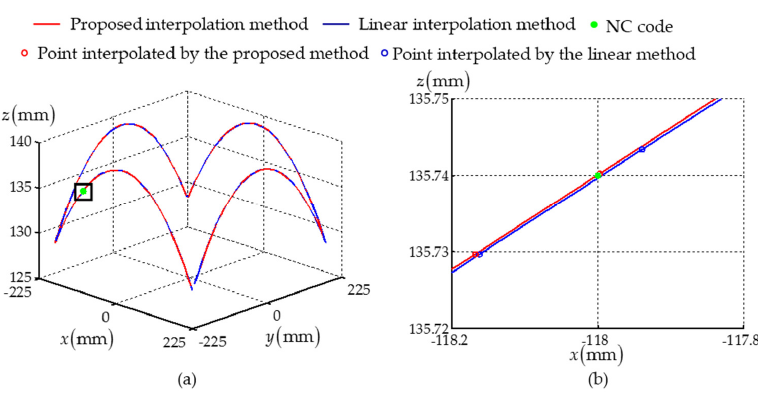
Figure 5. The end-point trajectory interpolated by different methods: ( a ) the end-point trajectory; and ( b ) the partial enlarged view.